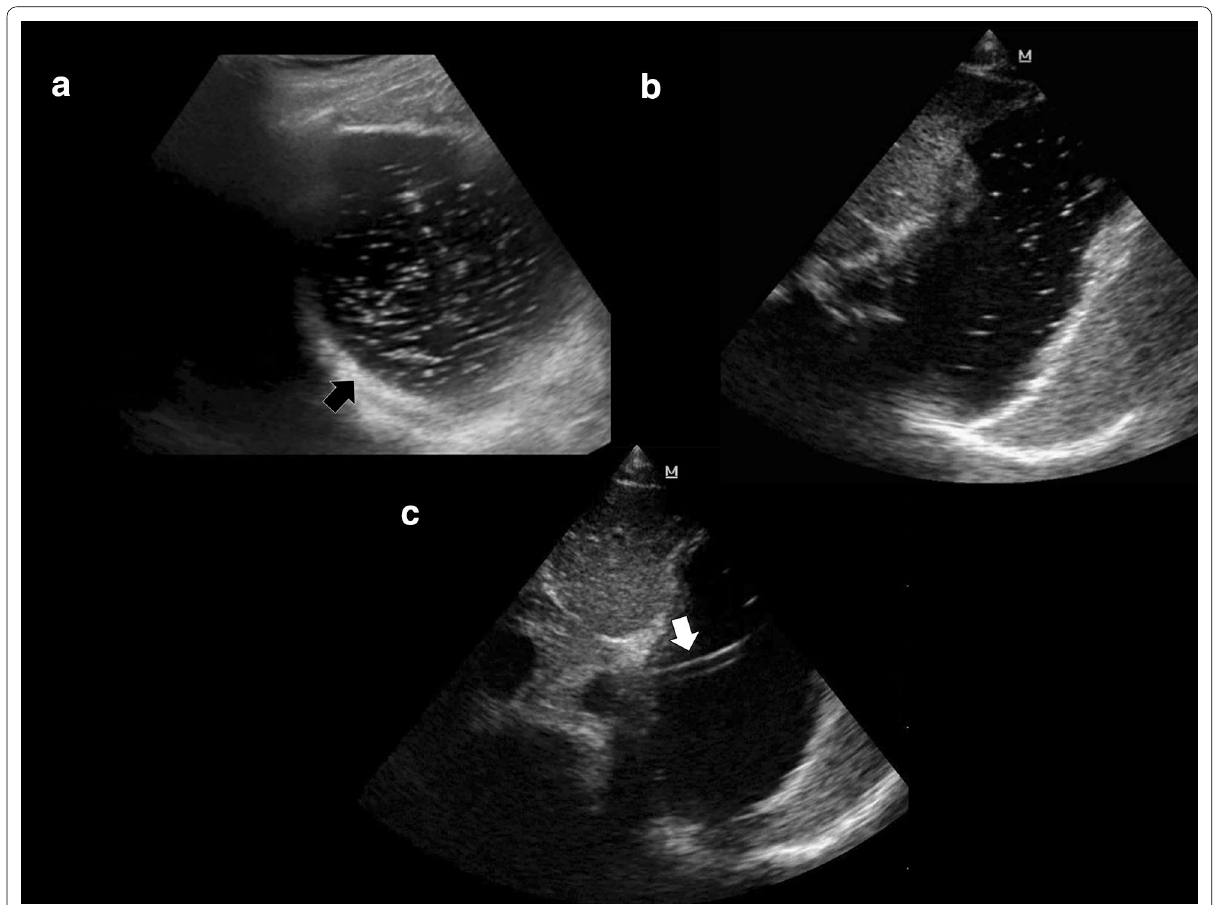
Fig. 4 a Stomach observed from the left coronal view. Note the fluid content and the echoes inside (air bubbles); arrow diaphragm. b Stomach observed from an epigastric view simulating a collection. c A gastric tube is observed confirming that it is the stomach ( white arrow )